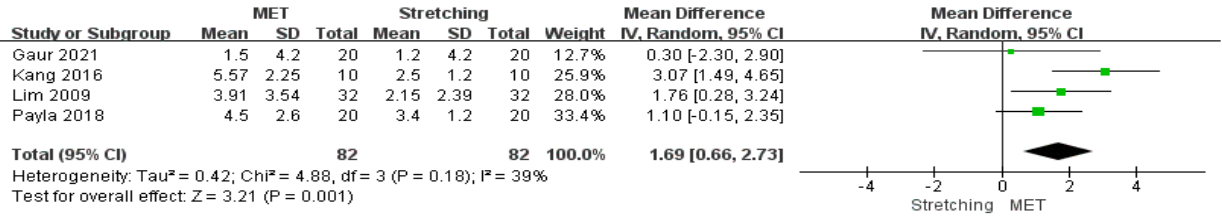
Figure 3. Meta-analysis of sit and reach test (SRT) outcomes of SRT compared between muscle energy technique (MET) and stretching groups [10,33,43,47]. SD: standard deviation; CI: confidence interval.